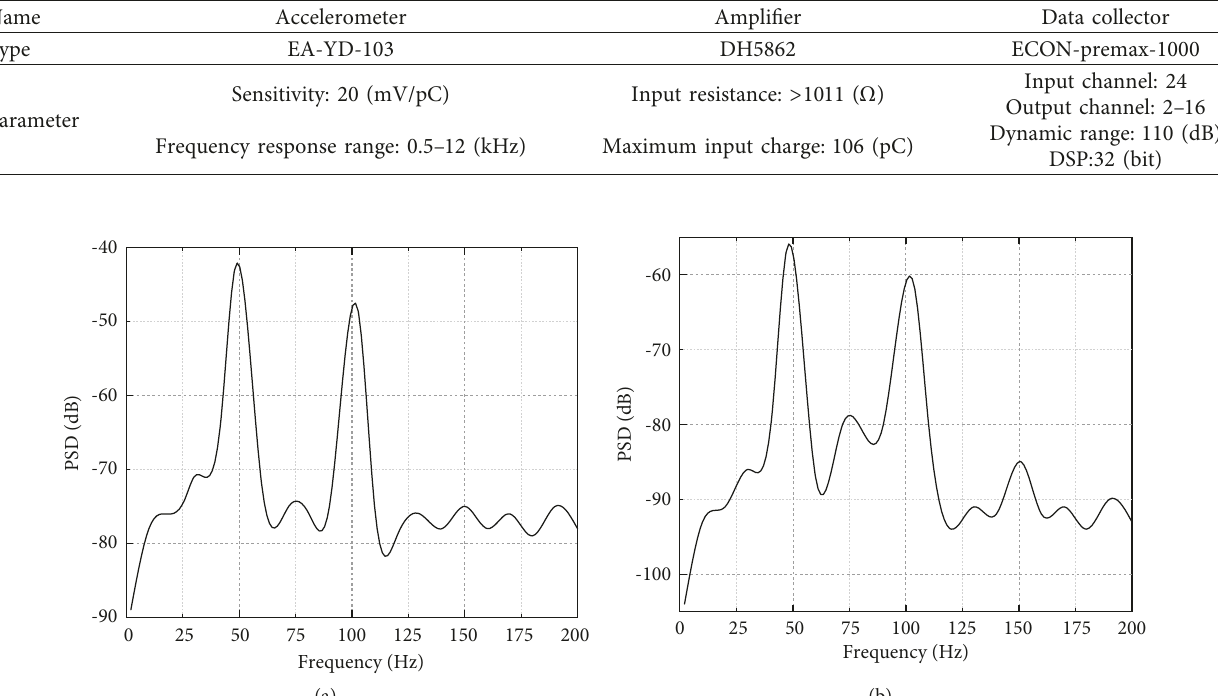
Figure 8: The peak-picking method for identifying the nature frequency for the foundation of stone cutting machine: (a) the noiseless input on point 1; (b) 60% white noise excitation input on point